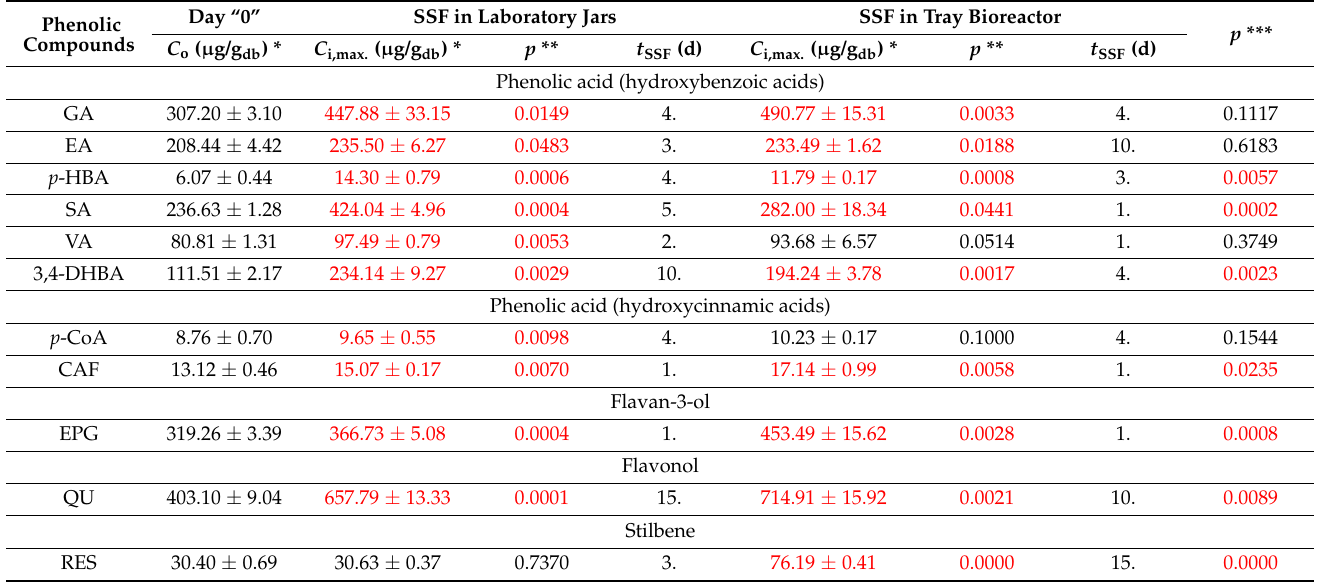
Table 5. The content of individual phenolic compounds in extracts obtained from GP before SSF (day “0”, C o ) and after SSF by R. oryzae in laboratory jars and in a tray bioreactor (maximum content of individual phenolic compounds in GP extracts recorded after a certain duration of SSF, C i,max.